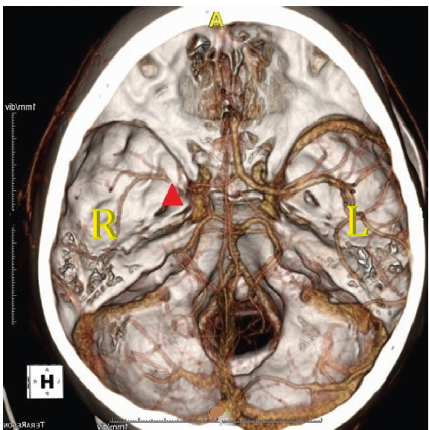
Figure 2: 3D reconstruction of the CTA showing stenosis or embolus in the right MCA.